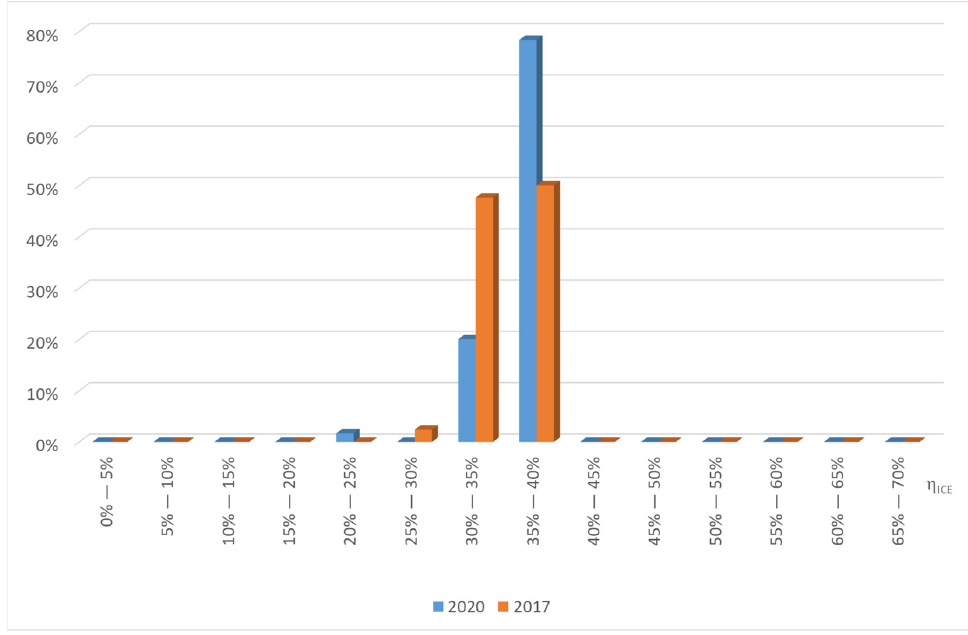
Figure 13. Frequency distribution of the ICE efficiency values.